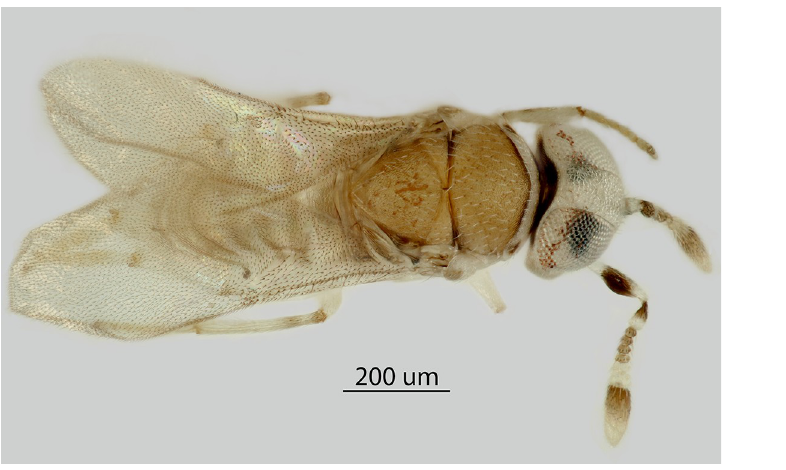
Fig 9. M . macadamiae female, dorsal